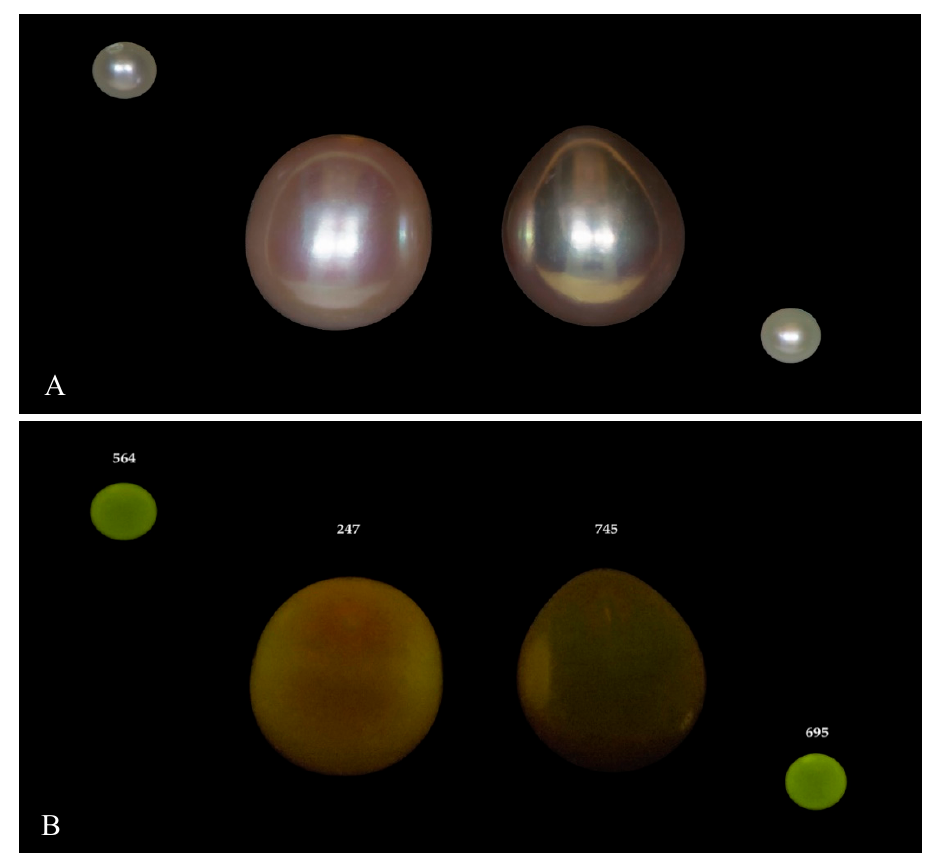
Figure 7. Freshwater samples under daylight ( A ) and under X-rays ( B ). Two natural-coloured freshwater samples (left sample of pink colour and right samples of grey colour) with the amount 55 Mn in ppmw. The two freshwater samples upper left (diameter: 2.85 mm) and bottom right (diameter: 2.95 mm) used as reference. For the samples 3 analyses with LA-ICP-MS were acquired, the average values are presented (rounded to the nearest one).